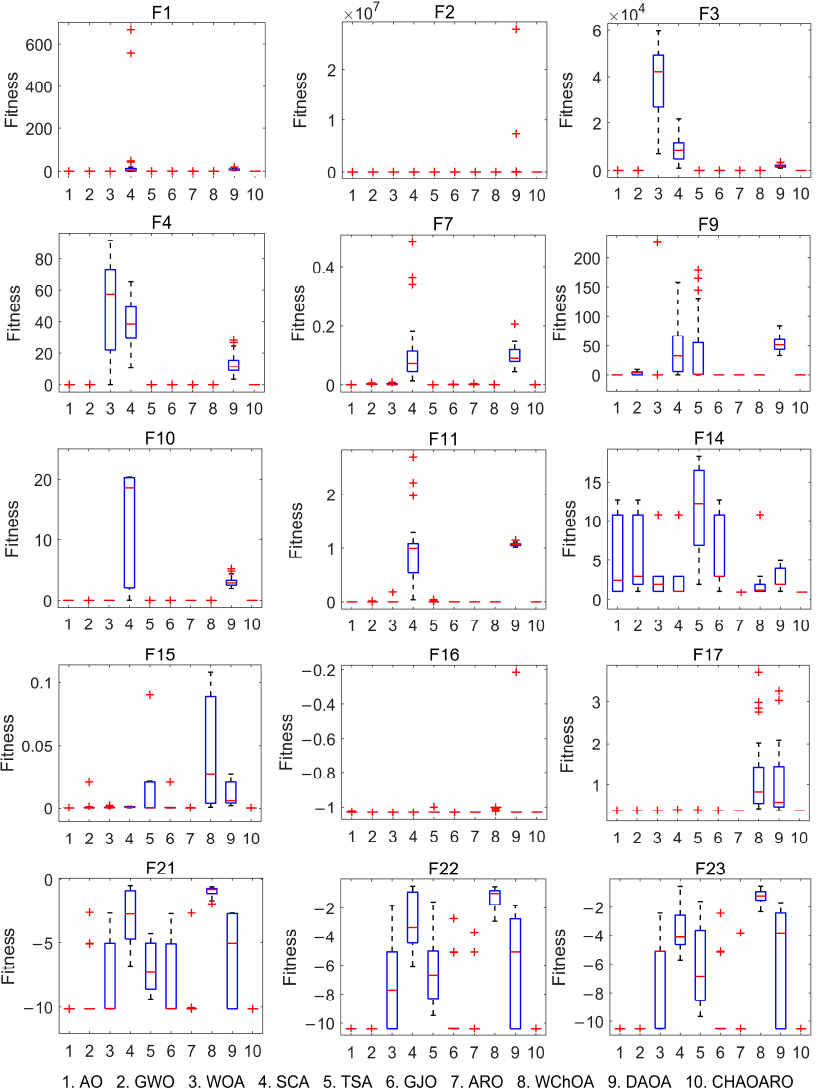
Figure 8. Boxplots of CHAOARO and other comparison algorithms on some benchmark functions.